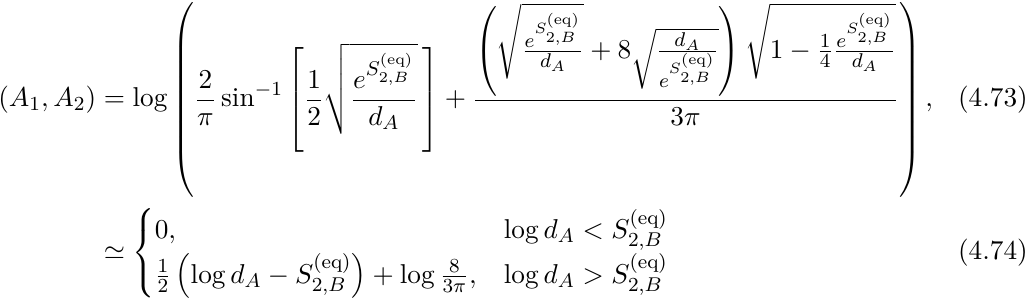
case. However, the transition from dominance of τ = e to τ = τ along the same line, indicated as the purple dashed line in the figure. This coincides with the transition in I from NE to ES, and takes place at a smaller value of c than the 2